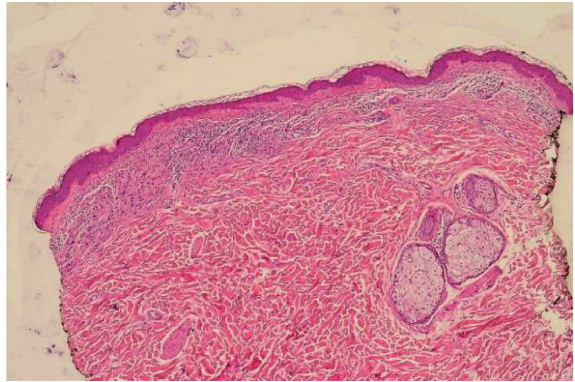
Figure 2: Intradermal atypical nevus cells in the left part of the biopsy, contrasting with regression in the right part (HE